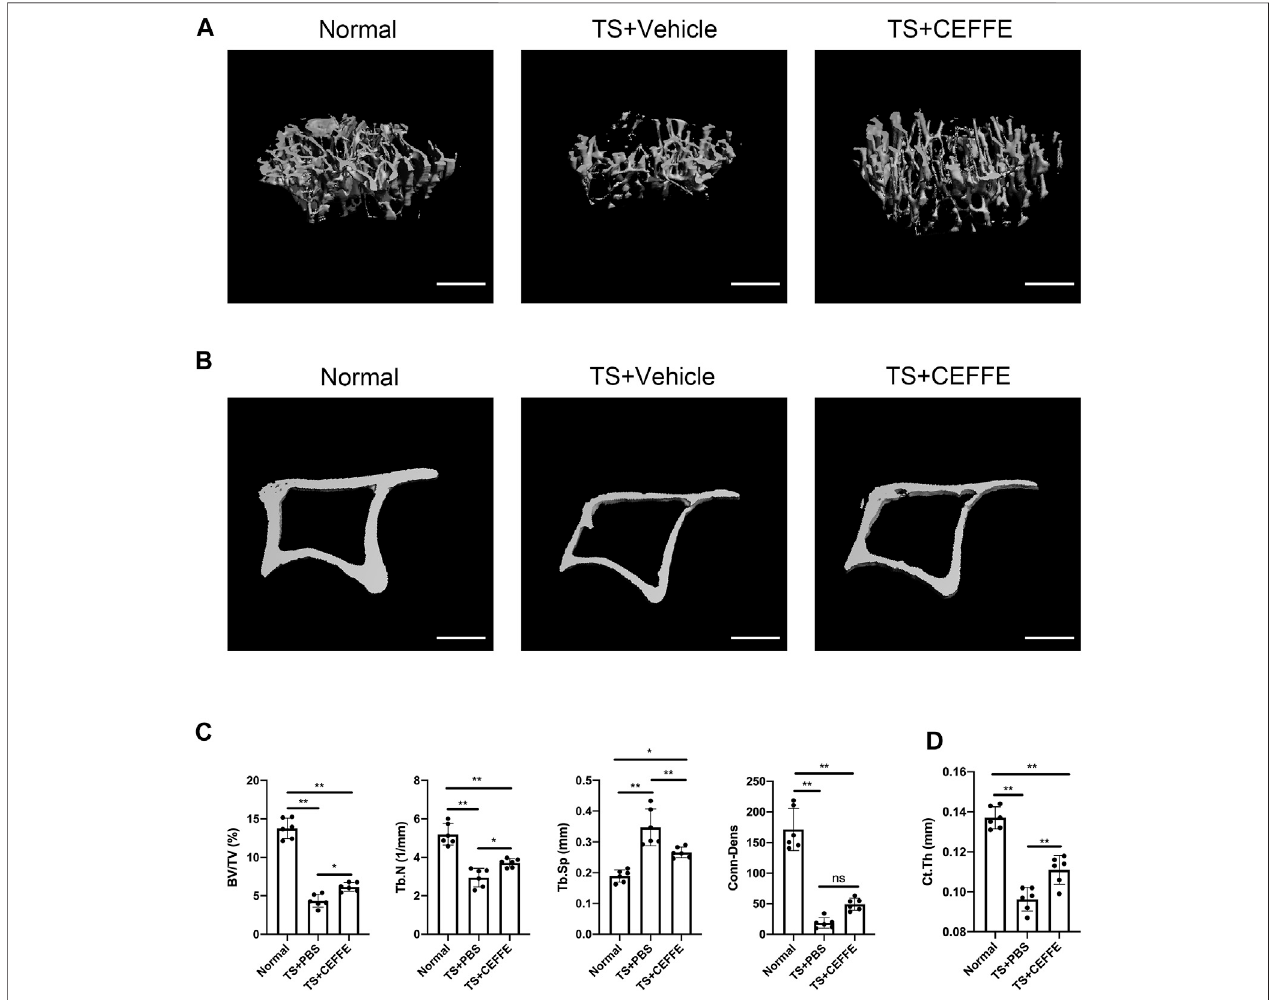
FIGURE 1 | CEFFE improved bone mass in osteoporotic mice induced by the tail suspension model. Three-dimensional (3D) reconstruction from microcomputed tomography (µC+T) scans of proximal tibia from normal mice, mice submitted to tail suspension + vehicle, and mice submitted to tail-suspension + CEFFE (A) . Representative μ CTimagesofthecorticalbone (B) .Quantitativeanalysesofthetrabecularboneoftheproximaltibia (C) ,andthecorticalbonethicknessinallgroups (D) . Scale bar, 500 μ m * p < 0.05, and ** p < 0.01.